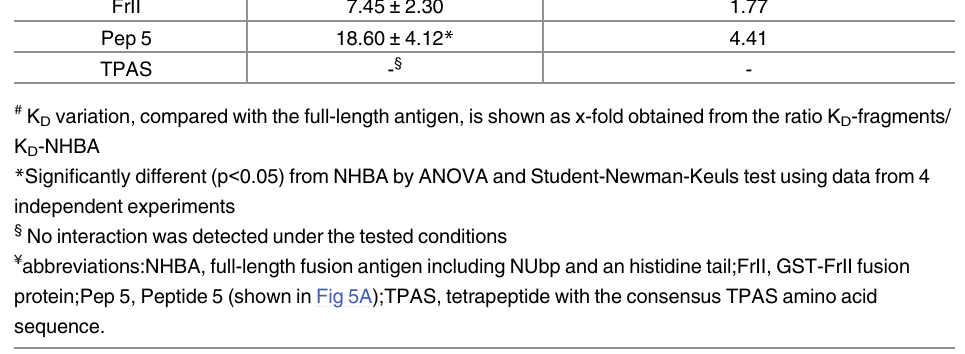
Table 1. Binding affinities of mAb 31E10/E7 for representative NHBA fragments.